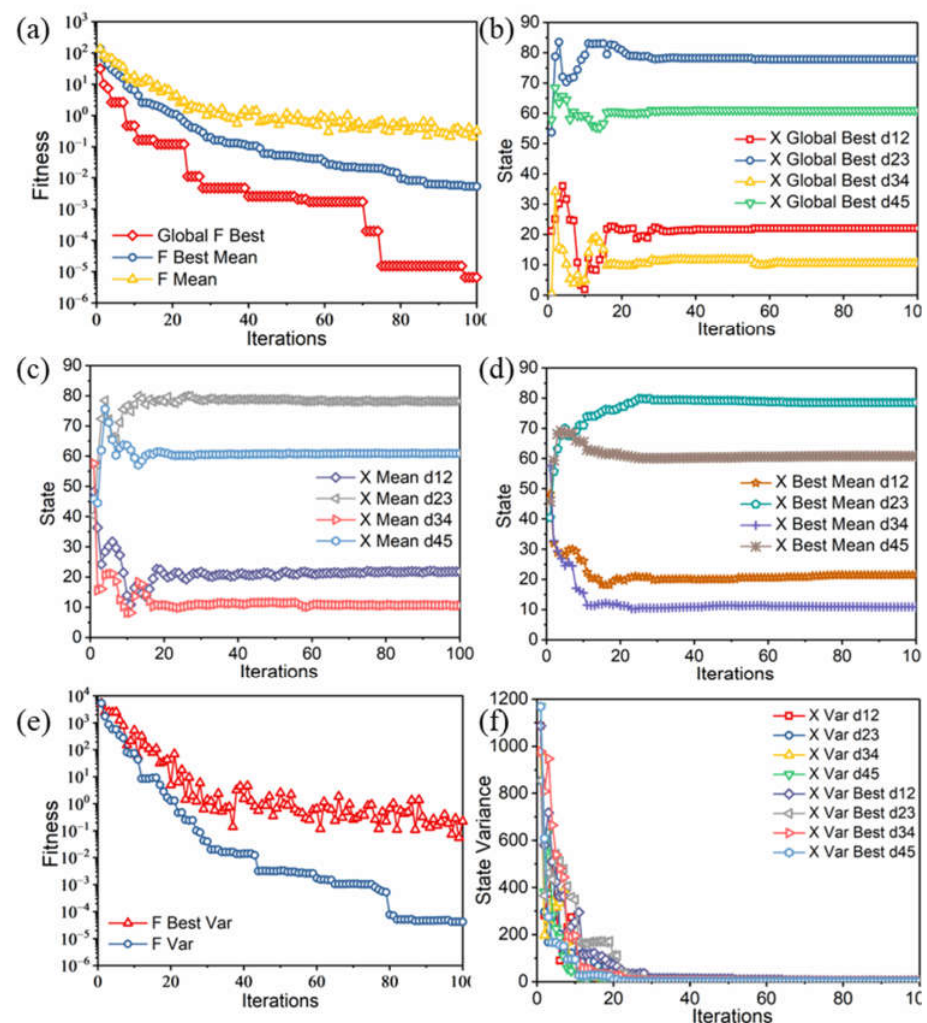
Figure 7. Search results of the APSO algorithm for the fore-catadioptric system: ( a ) the optimization result of objective function value of the APSO algorithm; ( b ) the global optimal parameters search results of the objective function; ( c ) the mean of the current global optimal parameters search results of the objective function; ( d ) the mean of the previous global optimal parameters results during the search process; ( e ) the optimization results of objective function variance value of APSO algorithm; ( f ) the results of the optimal parameters variance value.